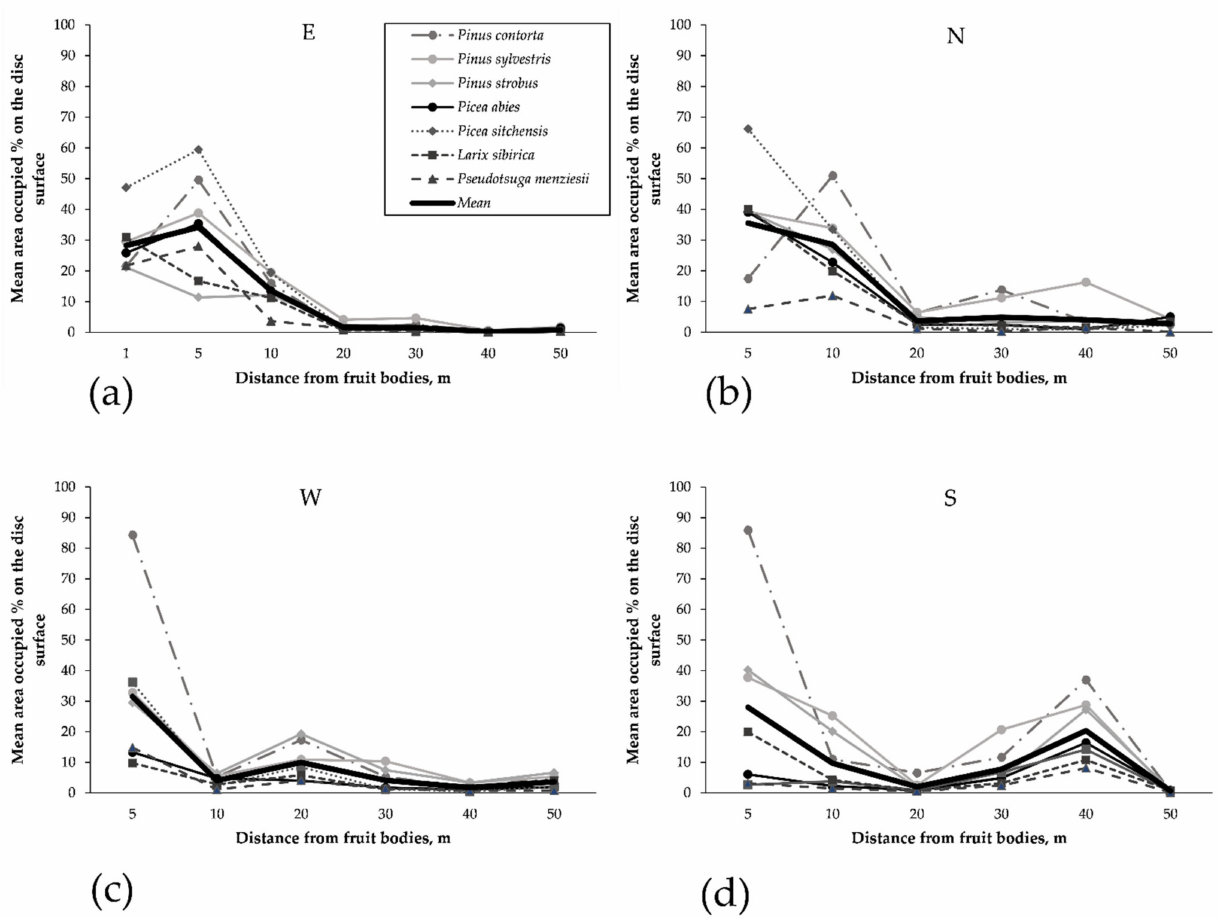
Figure 5. The rates of infection of wood discs of seven coniferous tree species by Heterobasidion annosum s.l. in the Kalsnava sample plot at increasing distances from spore sources. Disc exposition in different directions—( a ) east, ( b ) north, ( c ) west and ( d ) south; only in figure ( a ) the area occupied by Heterobasidion annosum s.l. at a distance “1 m” from the largest group of fruiting bodies is shown; the same numbers refer to other